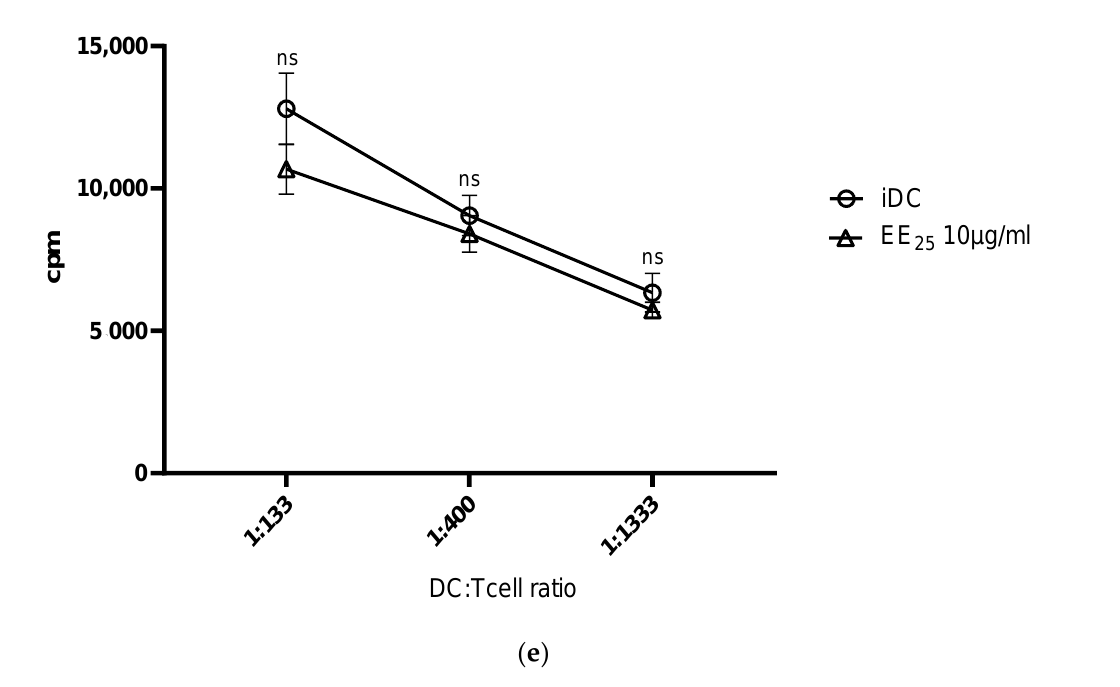
Figure 3. ( a ): MLR assays comparing untreated and EC15 treated iDCs. The effect of elderberry extract EC15 regarding the DC-mediated T cell stimulation was assessed using the mixed lymphocyte reaction (MLR) assay, in comparison to untreated iDCs. iDC were pre-treated with 10µg/mL EC15 for 24 h and co-cultured with allogeneic T-cells in the MLR assay. T-cell proliferation was measured upon 3H-thymidin incorporation. Asterisks mark statistically significant difference (* p < 0.05, *** p < 0.001 and **** p < 0.0001). ns: no statistical significance. (n = 6). ( b ): MLR assays comparing untreated and CPS treated iDCs. Description as Figure 3a. Asterisks mark statistically significant difference (*** p < 0.001 and **** p < 0.0001). ns: no statistical significance. (n = 6). ( c ): MLR assays comparing untreated and BOUND treated iDCs. Description as Figure 3a. Asterisks mark statistically significant difference (**** p < 0.0001). ns: no statistical significance. (n = 3 – 6). ( d ): MLR assays comparing untreated and UNBOUND treated iDCs. Description as Figure 3a. Asterisks mark statistically significant difference (**** p < 0.0001). ns: no statistical significance ( n = 3–6). ( e ): MLR assays comparing untreated and EE25 treated iDCs. Description as Figure 3a. ns: no statistical significance. ( n =